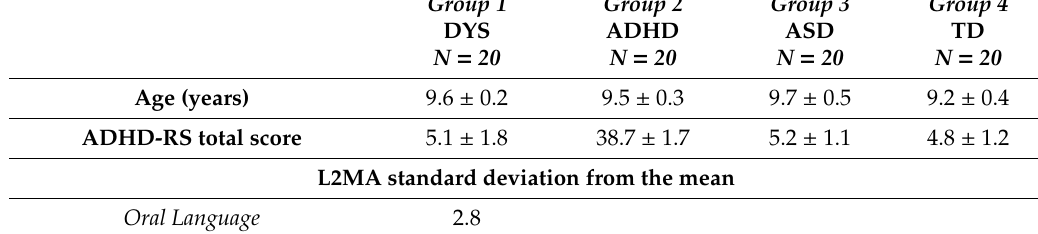
Table 1. Clinical characteristics (mean, standard deviation of the test score) in four groups of children tested (DYS, children with dyslexia; ADHD, children with attention deficit hyperactivity disorder; ASD, children with autism spectrum disorders; TD, children with typical development). For the L2MA test done in children with dyslexia, the standard deviation from normal mean is reported. ADHD-RS, ADHD rating scale parental report; L2MA, oral language, written language, memory, attention. Group 2 Group 1 ADHD DYS N = N = 20